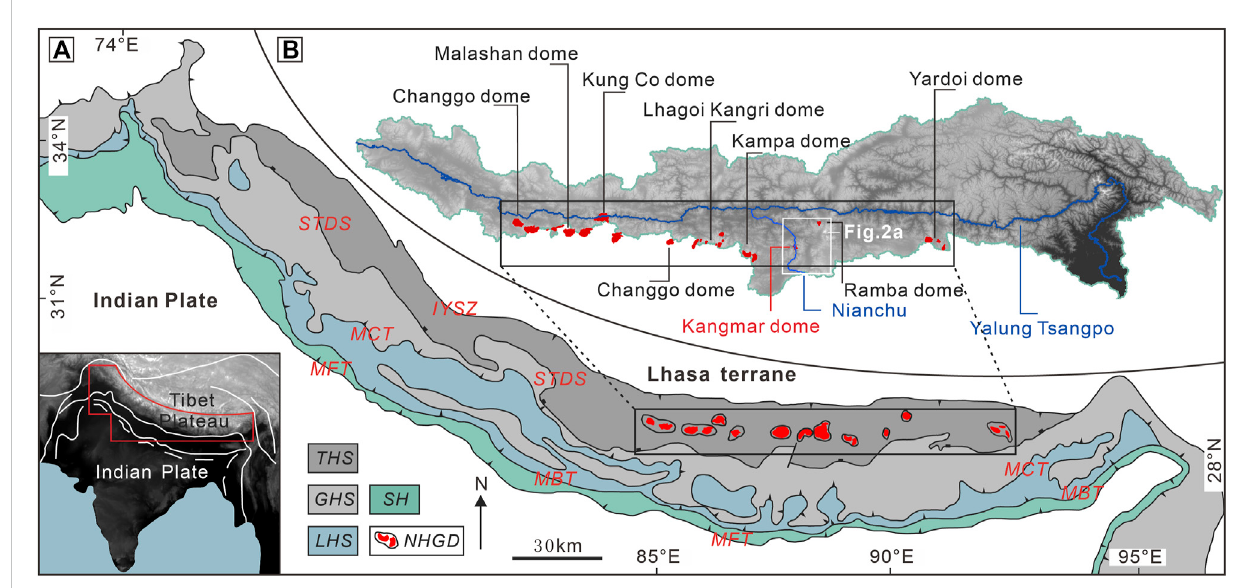
FIGURE 1 (A) Simpli fi edgeologic mapof theHimalayan orogenicbelt, southernTibet,showing locations oftheNorth HimalayanGneissDome(modi fi edafter Wangetal.,2022). (B) Simpli fi edgeologicmapoftheYarlungTsangpocatchment,showingtherelativelocationsoftheNGHD,NianchuRiverandYalung Tsangpo River. MBT, Main Boundary thrust; MCT, Main Central thrust; MFT, Main Frontal thrust; STDS, South Tibetan detachment system; IYSZ, Indus- Yarlung suture zone; THS, Tethys Himalaya Sequence; GHS, Grater Himalaya sequence; LHS, lesser Himalaya sequence; SH, sub-Himalaya; NHGD, North Himalayan Gneiss